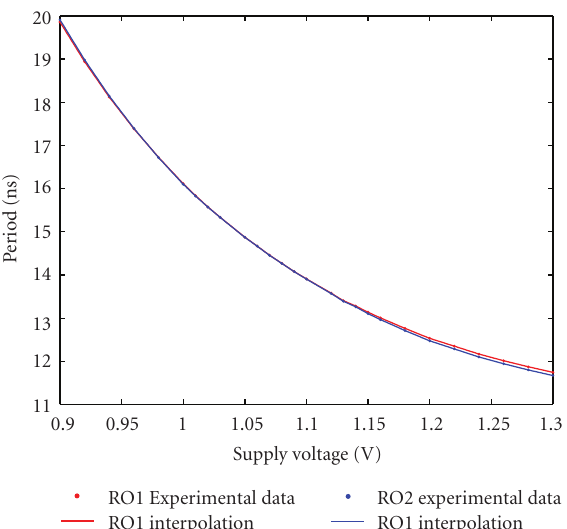
Figure 11: Dependence of clock periods of two rings in Actel Fusion device on the power supply.